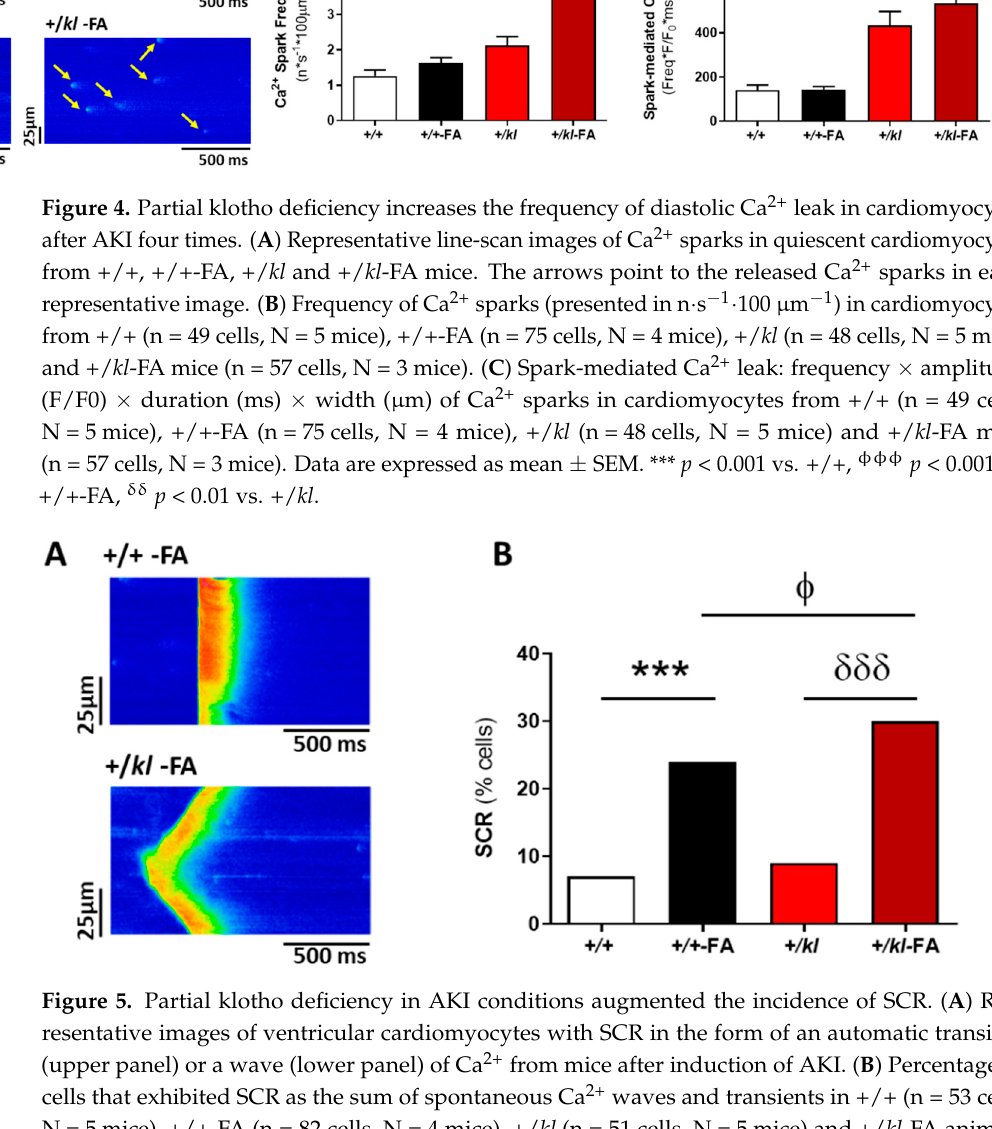
Figure 5. Partial klotho deficiency in AKI conditions augmented the incidence of SCR. ( A ) Repre- sentative images of ventricular cardiomyocytes with SCR in the form of an automatic transient (up- per panel) or a wave (lower panel) of Ca 2+ from mice after induction of AKI. ( B ) Percentage of cells that exhibited SCR as the sum of spontaneous Ca 2+ waves and transients in +/+ (n = 53 cells, N = 5 mice), +/+-FA (n = 82 cells, N = 4 mice), +/ kl (n = 51 cells, N = 5 mice) and +/ kl -FA animals (n = 64 cells, N = 3 mice). Data are expressed as a percentage. *** p < 0.001 vs. +/+, ϕ p < 0.05 vs. +/+-FA, δδδ p < 0.001 vs. +/ kl .